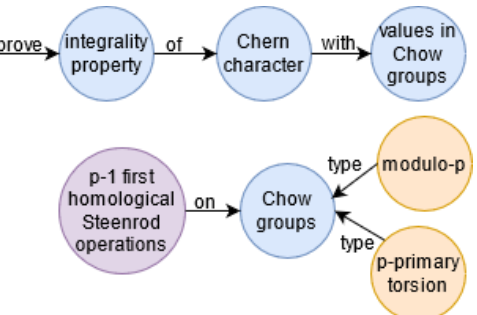
Figure A2. Structured KG representation of a Mathematics domain publication Abstract [66] as process, method, material, and data